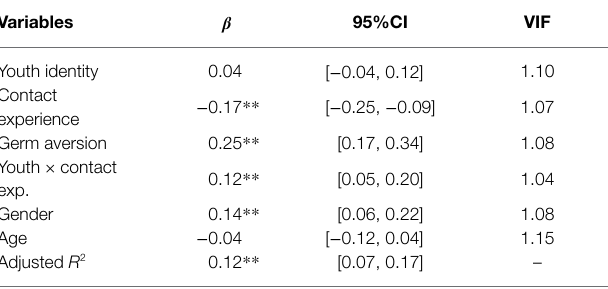
N = 563. Regression coefficients are standardized. The numbers in parentheses represent 95% confidence intervals for regression coefficients and adjusted R 2 . Gender: Males were assigned a score of 1, whereas females were given a score of 0. ** p < 0.01, * p < 0.05.